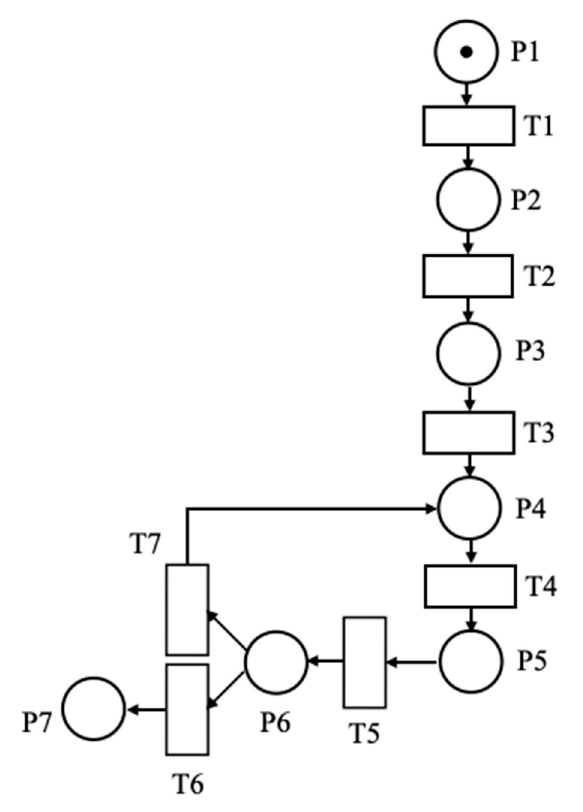
Figure 3. A spatial-temporal hybrid Petri net model of a UAV attack process.